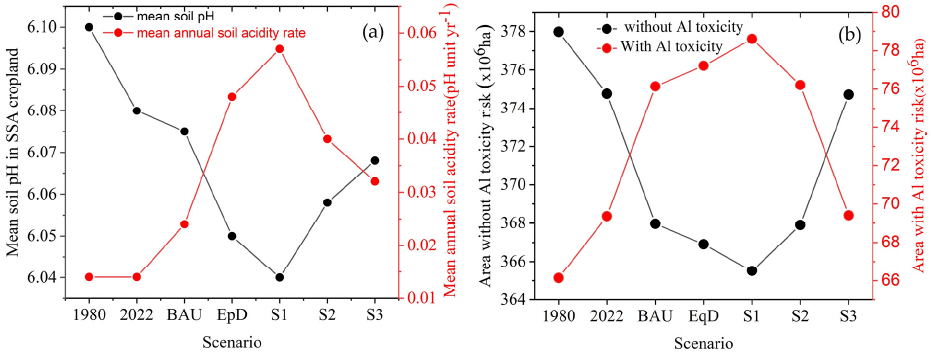
Figure 10. Temporal variation in mean soil pH of SSA croplands ( a ) and variation in croplands affected by aluminum toxicity in the different scenarios ( b ). BAU: business-as-usual scenario (ammonium-based fertilizer and crop production for 2022 to 2050) followed the same trends as those of the last 42 years); EqD: equitable diet scenario (self-sufficiency); S1: increase of 20% in use of N fertilizers in the EqD scenario; S2: decrease of 20% in use of N fertilizers in the EqD scenario; and S3: decrease of 40% in use of N fertilizers in the EqD scenario. See Figure S7 for spatial and temporal changes in the estimated area affected by aluminum toxicity in SSA croplands.